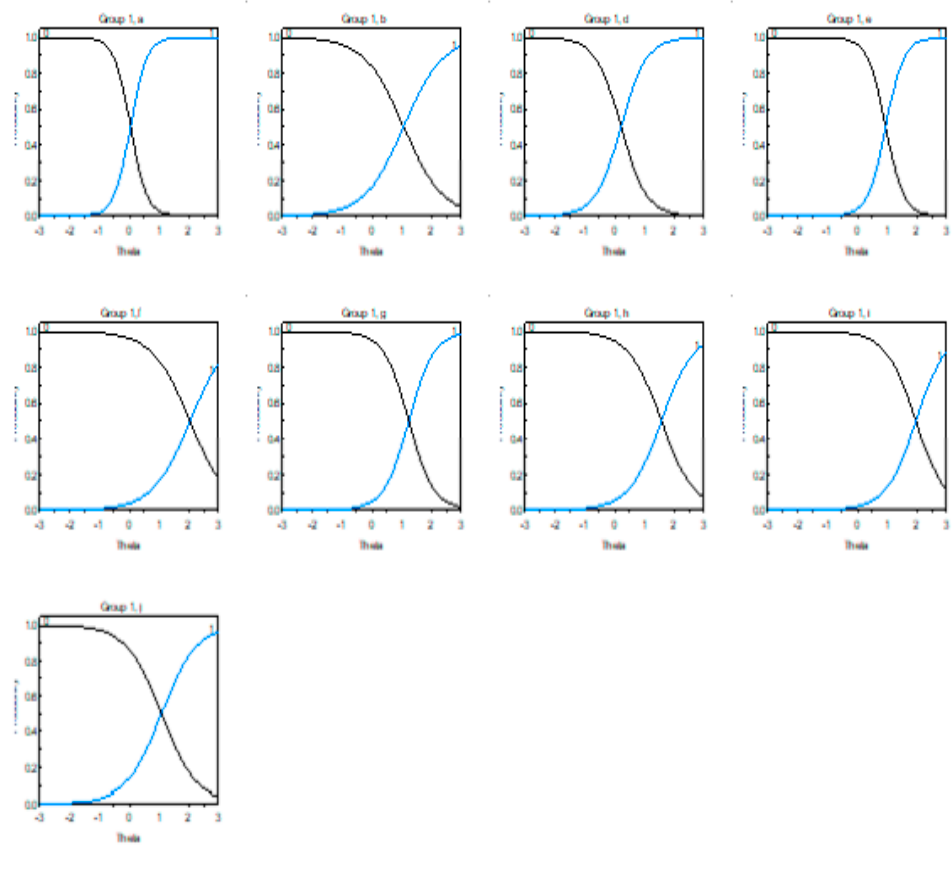
Figure 1. Item characteristic curves. Table 2. Item response scores.